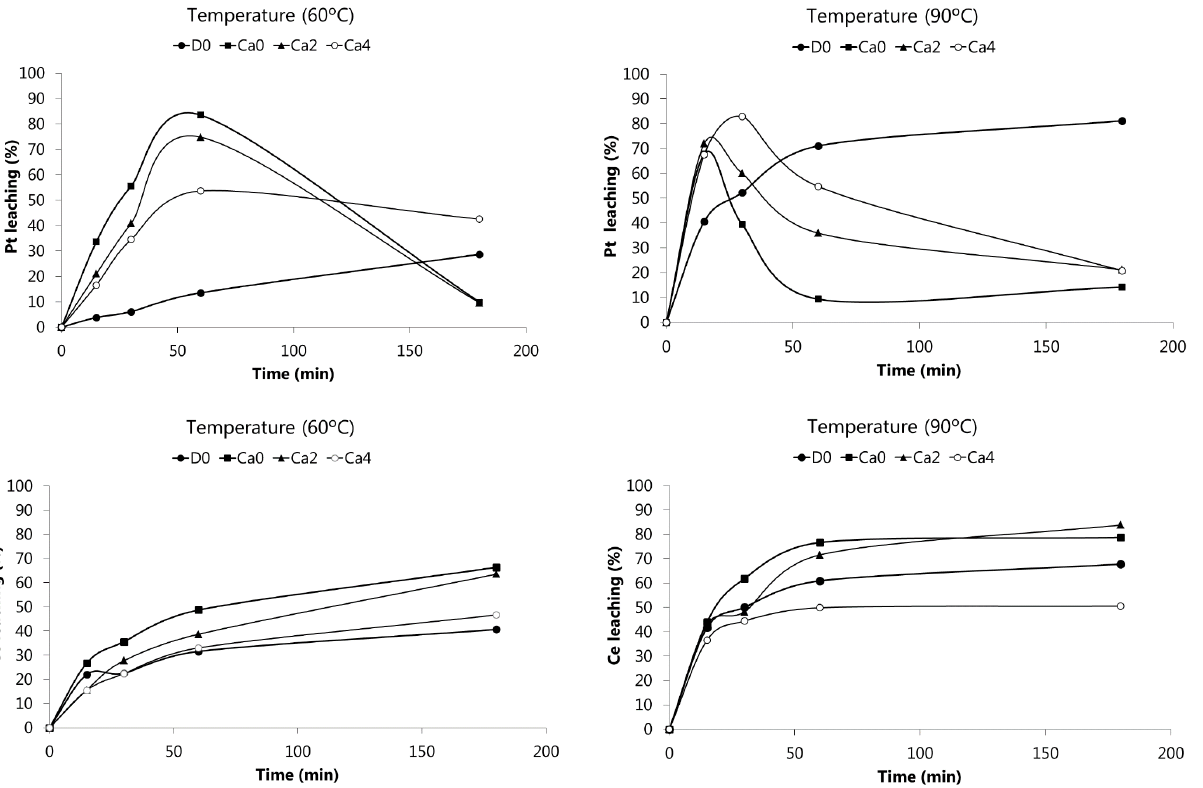
Figure 2. Leaching of Pt and Ce (wt%) from the SAAC at 60 and 90 ◦ C. The experimental results obtained showed that the percentage of Pt leaching greatly depend on the leaching solution used, on time and temperature. When 4 M HCl was used as leaching agent (solution D0, see Materials and Methods), the concentration of Pt in the leaching liquor increased with time and temperature, with a maximum value of 81% at 90 ◦ C after 3 h of leaching. Leaching solutions with a higher chloride concentration (Ca0, Ca2, Ca4) turned Pt leaching faster (yields above 80% at 30 min for Ca4 at 90 ◦ C, or 1 h for Ca0 at 60 ◦ C). However, after a maximum value leaching, the concentration of Pt in solution significantly decreased (except for Ca0), probably due to a drop in the electrochemical potential leading to reduction and reprecipitation of Pt. This occurred as the oxidant (H 2 O 2 ) was consumed by the chemical reactions, and also by decomposition. H 2 O 2 decomposition helps to explain why the effect was more pronounced at higher temperatures, since the H 2 O 2 decomposition phenomenon is also